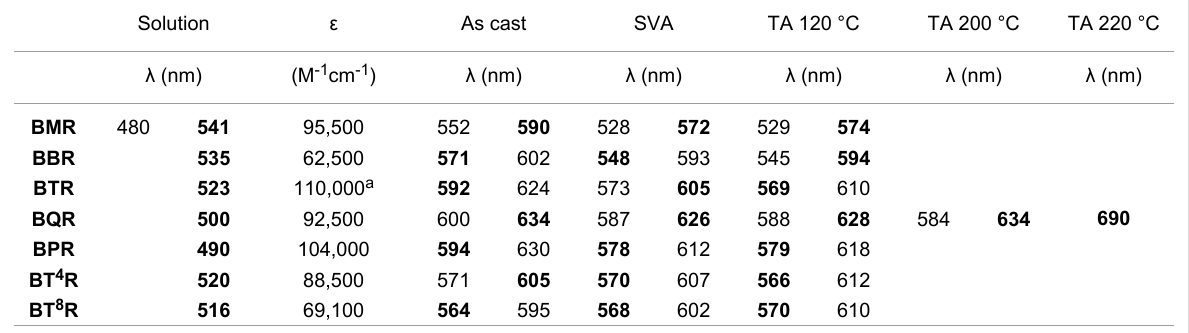
Table 1: Extracted UV–vis absorption peak positions for the BX x R series. ( λ max in bold).